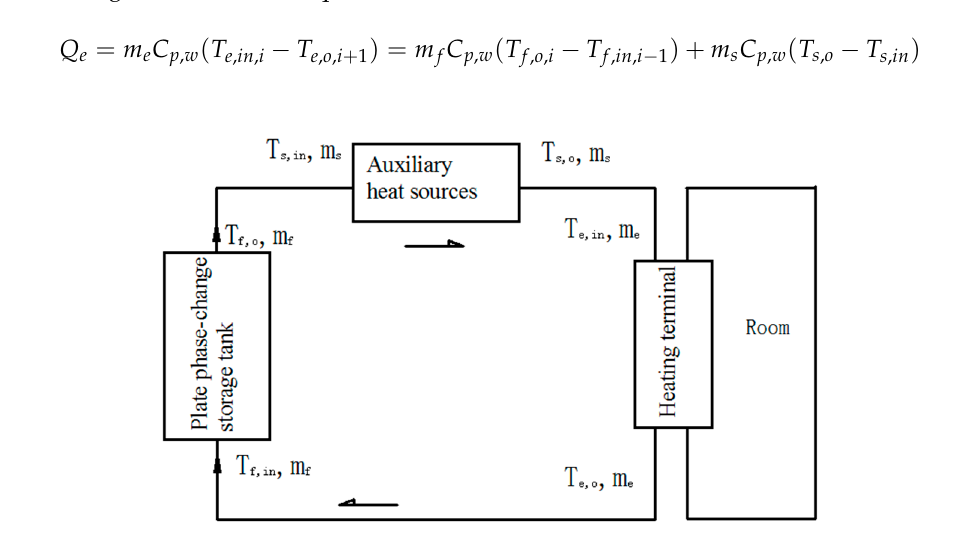
Figure 12. Operation model of the heat supply to the room from the phase-change thermal tank and auxiliary heat sources.